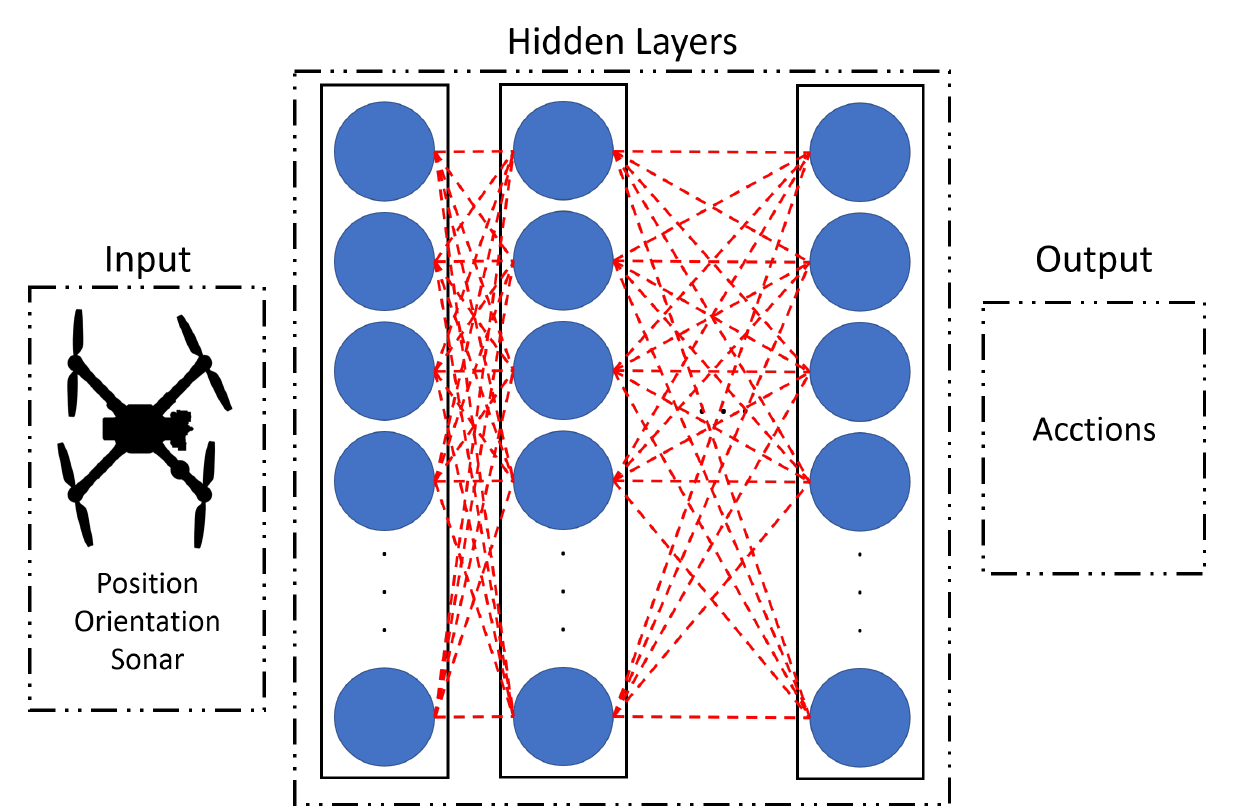
Figure 14. General structure of the Artificial Neural Network (ANN) used in the Deep Q-Network (DQN) algorithm. 1.